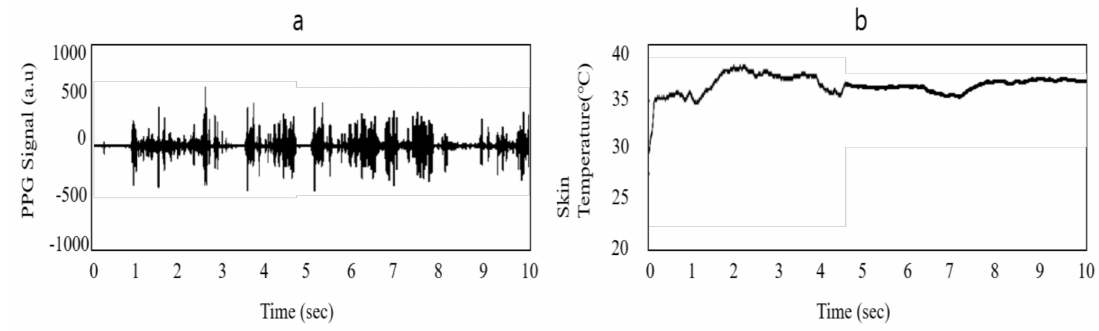
Figure 6. Filtered form of signals from PWB-300: ( a ) PPG signal and ( b ) skin temperature